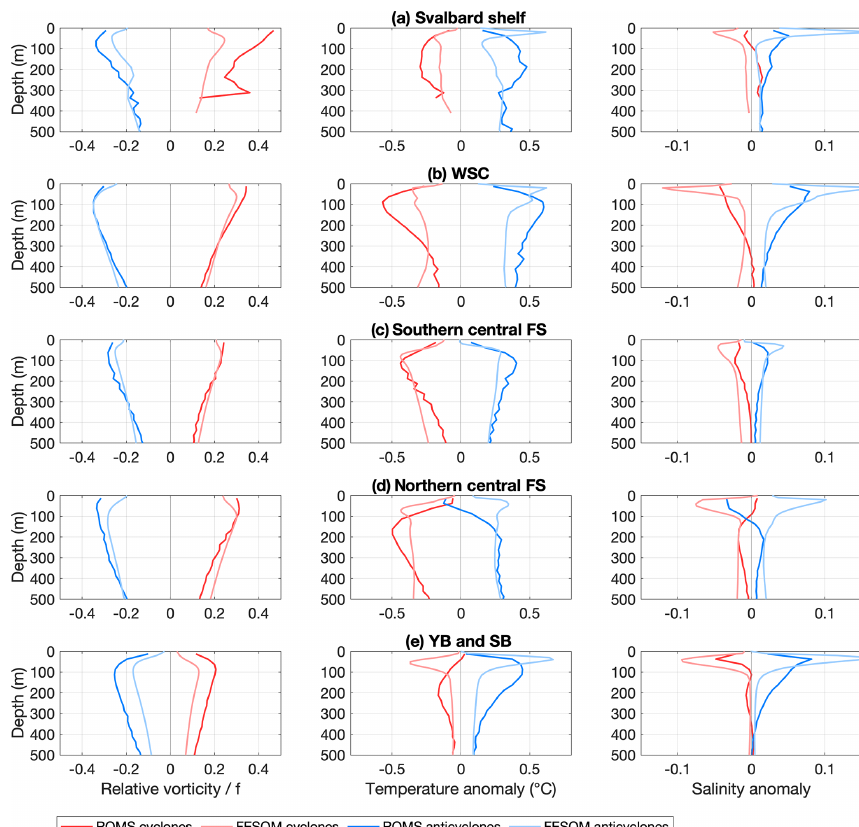
Figure 10. Vertical structure of eddies tracked at a depth of 100m during the years 2006–2009 in ROMS (dark colours) and FESOM (light colours) with lifetimes > 30d for cyclones (red) and anticyclones (blue) generated in the regions (a) Svalbard shelf, (b) West Spitsbergen Current, (c) southern central Fram Strait, (d) northern central Fram Strait, and (e) Yermak and Svalbard Branch. The left, middle and right columns show relative vorticity, temperature anomaly and salinity anomaly, respectively. Anomalies are calculated by taking the value in the eddy centre relative to the mean value of the month.